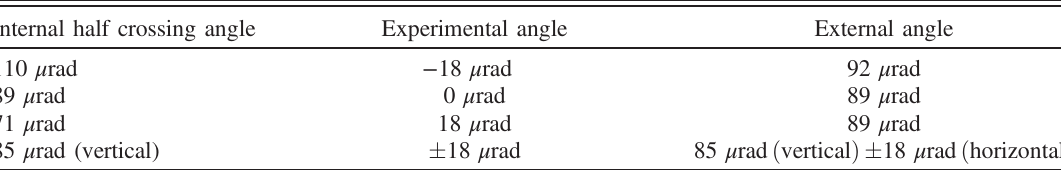
TABLE IV. Crossing schemes with similar long range beam-beam